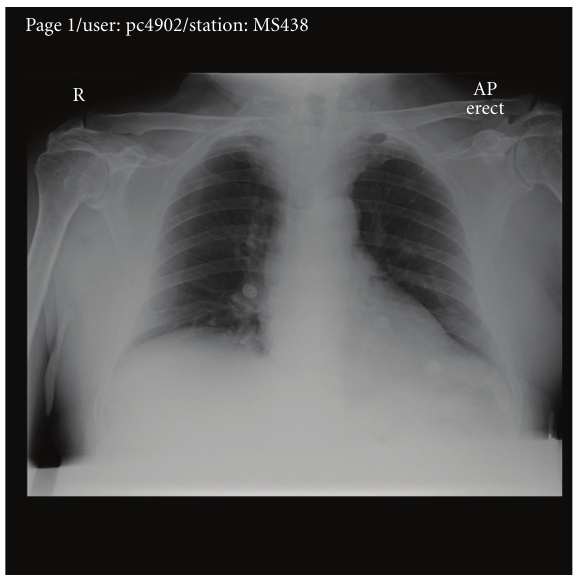
Figure 1: Chest X-Ray showing widened superior mediastinum.